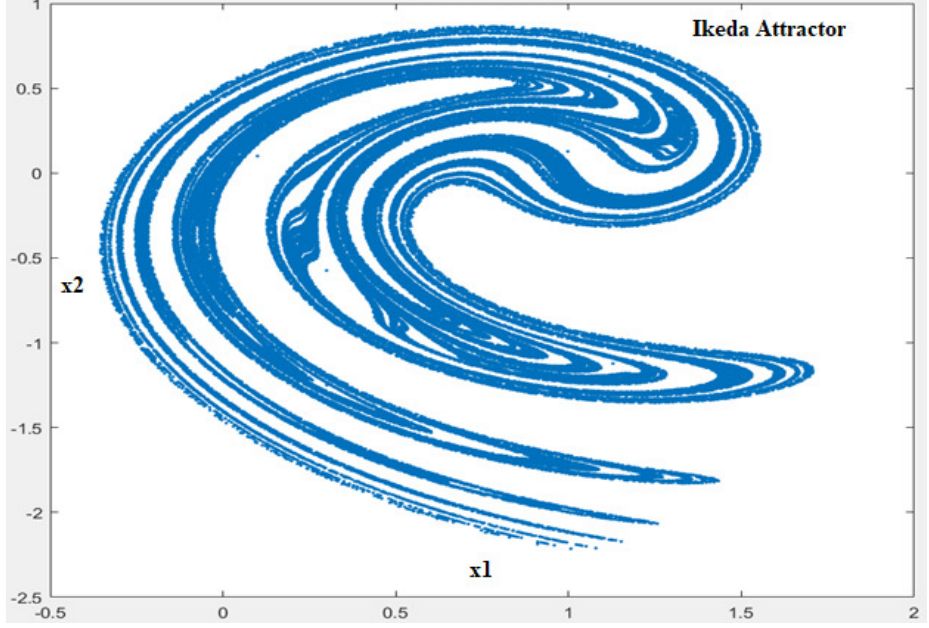
Figure 2. The Ikeda attractor.